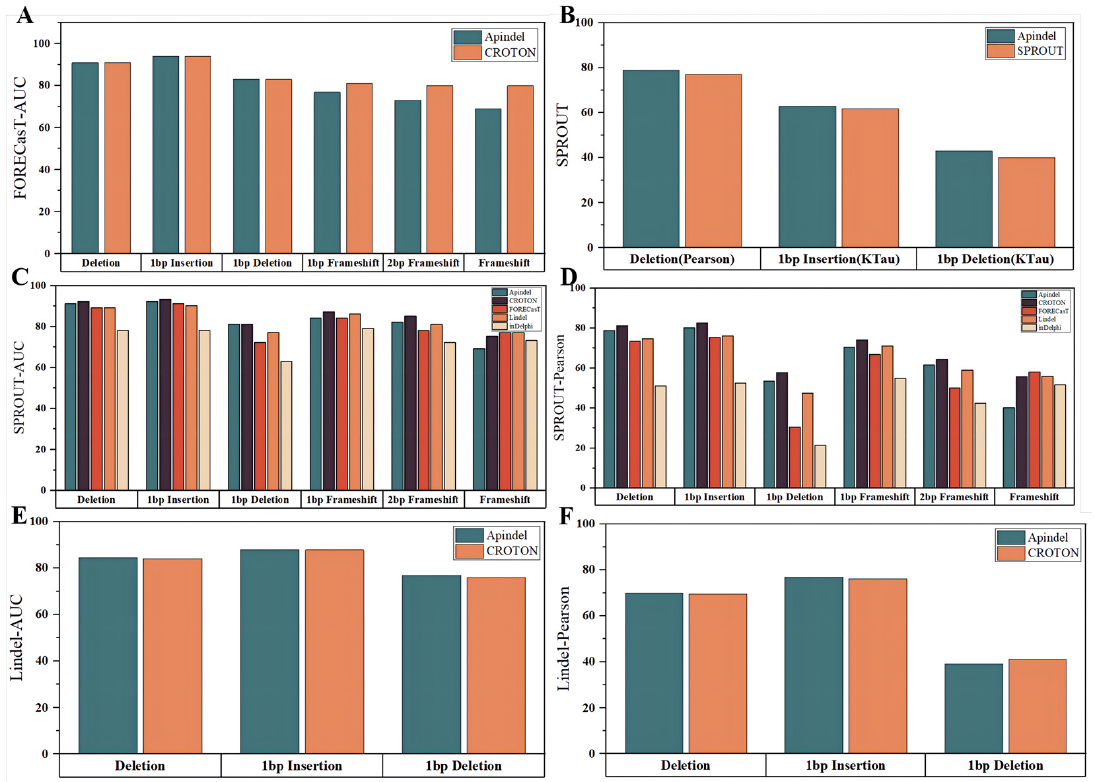
Figure 4. Performance comparison. The horizontal coordinates indicated the prediction tasks and the vertical coordinates indicated the prediction performance of the models on the corresponding datasets, characterized by the corresponding evaluation metrics. Different colors indicated different models. ( A ) Shows the AUC values of Apindel and CROTON on the FORECasT test set. ( B ) Indicates the comparison of the prediction performance of Apindel and SPROUT on the SPROUT test set. ( C , D ) Denotes the AUC values and Pearson correlation coefficients of Apindel, inDelphi, CROTON, FORECasT, and Lindel on the SPROUT test set. ( E , F ) Represents the comparison of Apindel and CROTON on the Lindel test